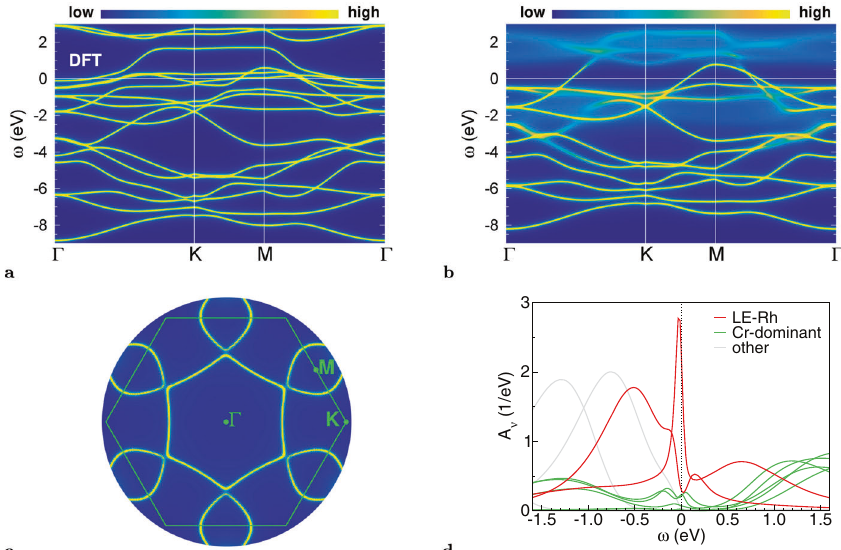
Fig. 9 Spectral properties of hypothetical RhCrO 2 . a DFT band structure, b – d DFT + DMFT features: b spectral function A ( k , ω ), c Fermi surface and d k -integrated Bloch contribution A ν ( ω ) with characterization of